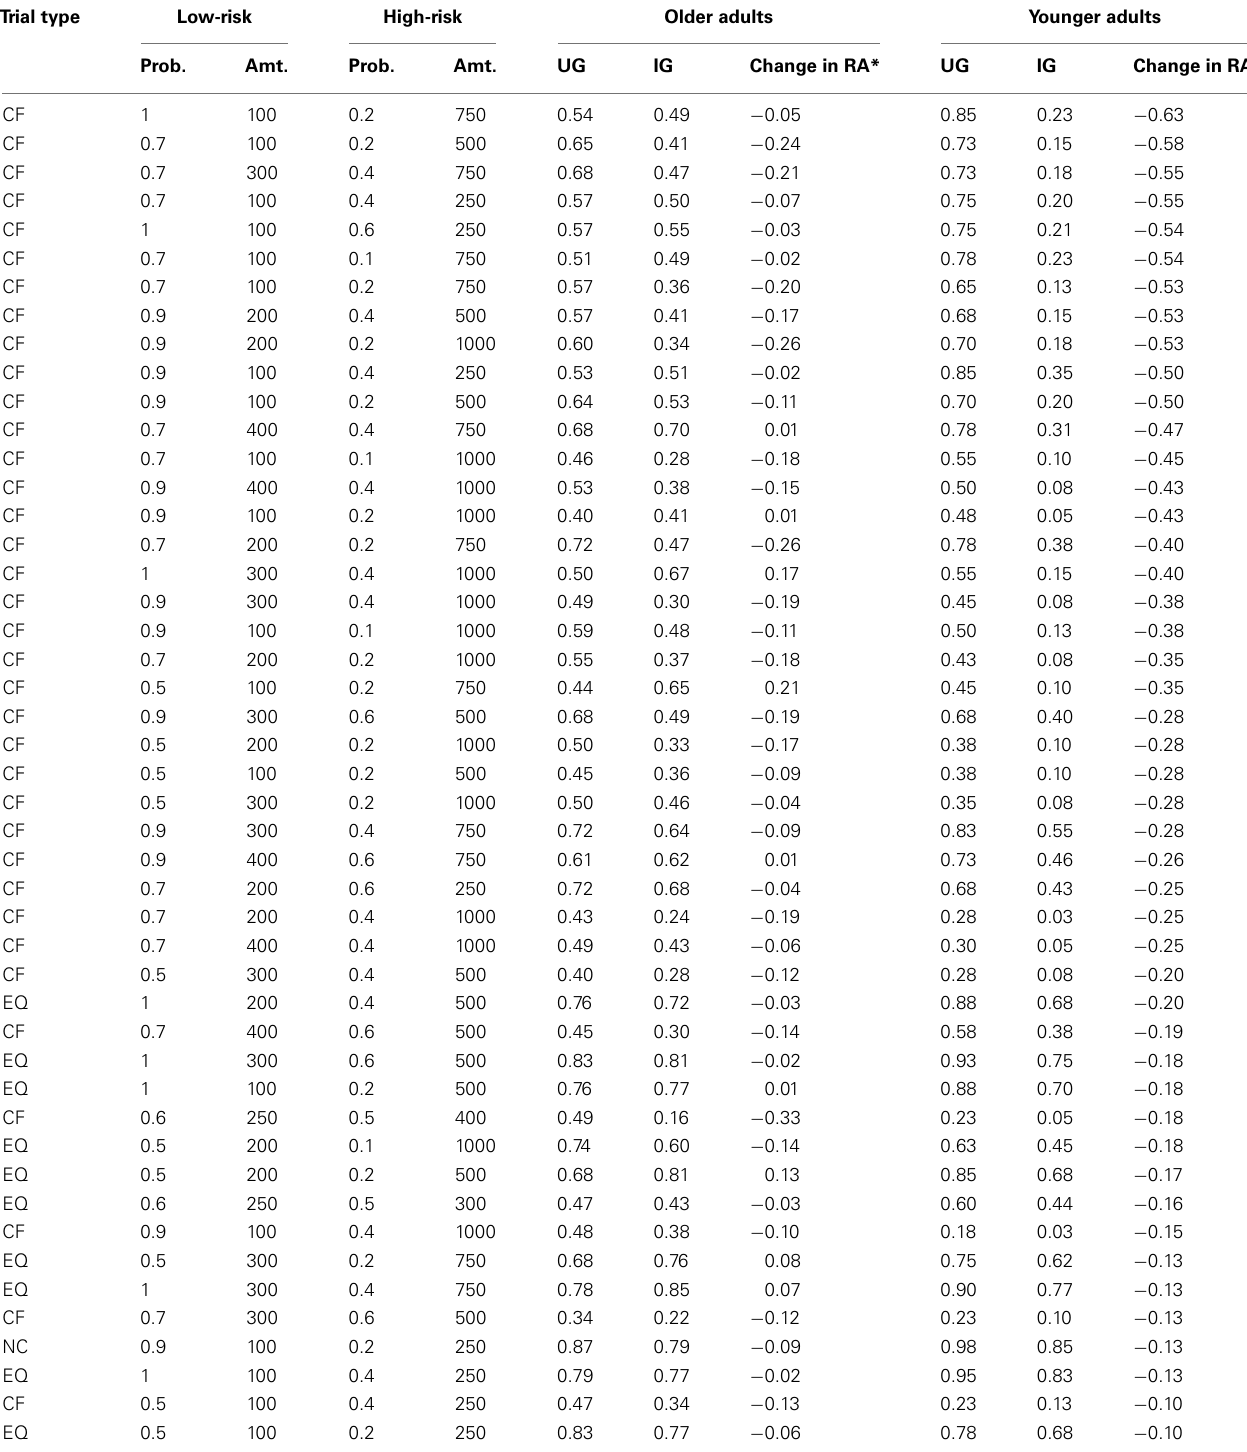
TableA1 | Parameters for each of the 96 trials as well as average rate of risk aversion on each trial both in uninstructed gambling (UG) and instructed gambling (IG), after the training;Trial types include conflict (CF), Non-conflict (NC), for which the high expected value option also has the higher probability, and Equivalence (EQ) trials for which the expected value of the two options is